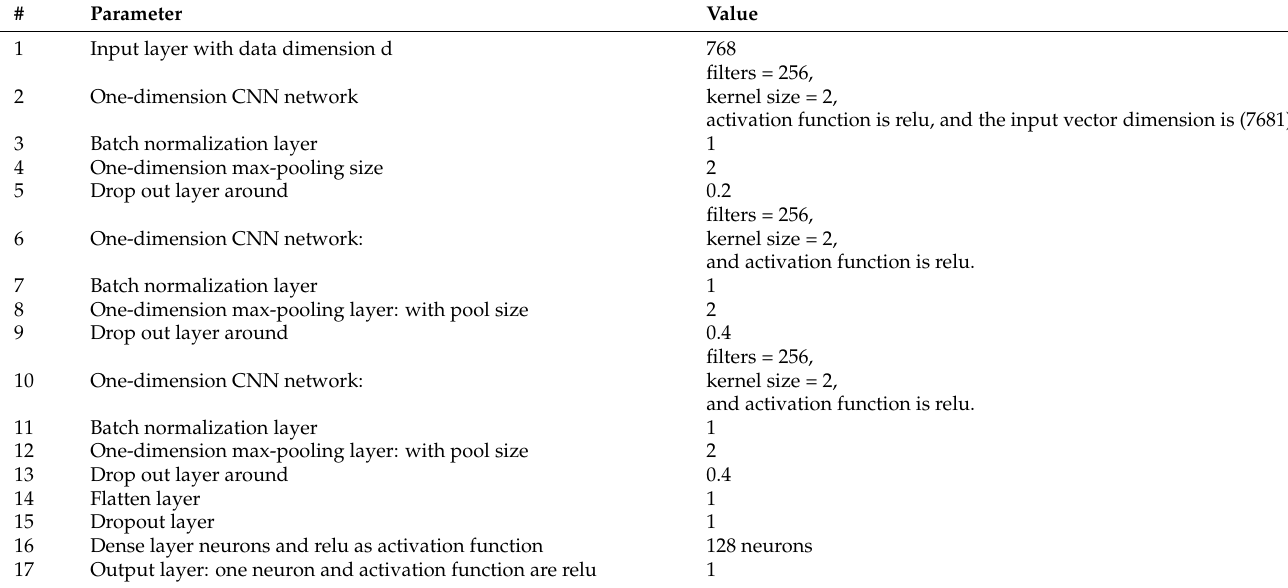
Table 4. Deep neural network topology